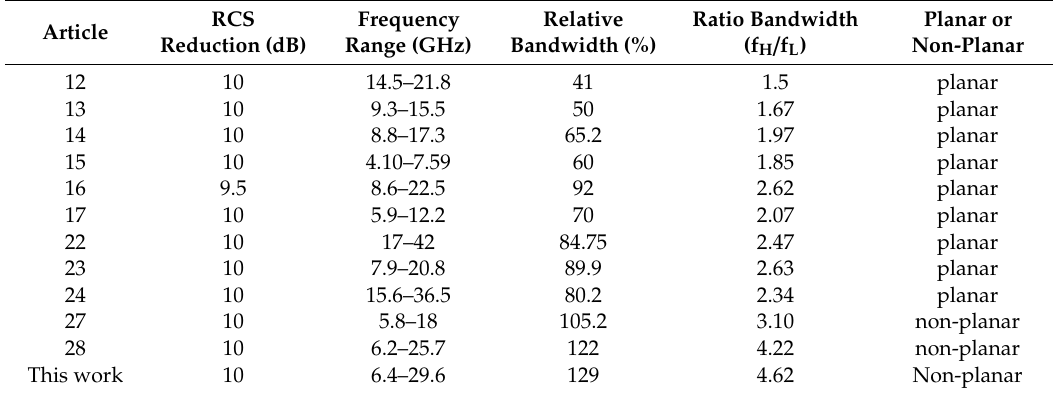
Figure 13. The simulation and measurement of the bistatic RCS reduction under the x-polarized in the incident angle θ = 30 ◦ and 45 ◦ . Table 1. Comparison of this work and previous